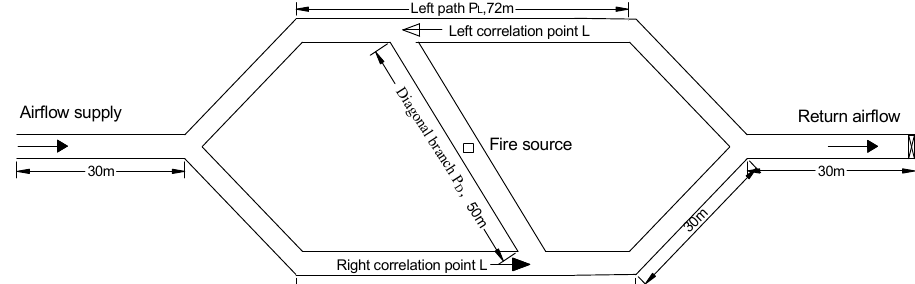
Figure 1. Tunnel fire smoke development process. (a) To (b) is the axisymmetric plume stage. (b) To (c) is the ceiling jet stage. (c) To (d) is the stage when the smoke layer hits the side wall of the